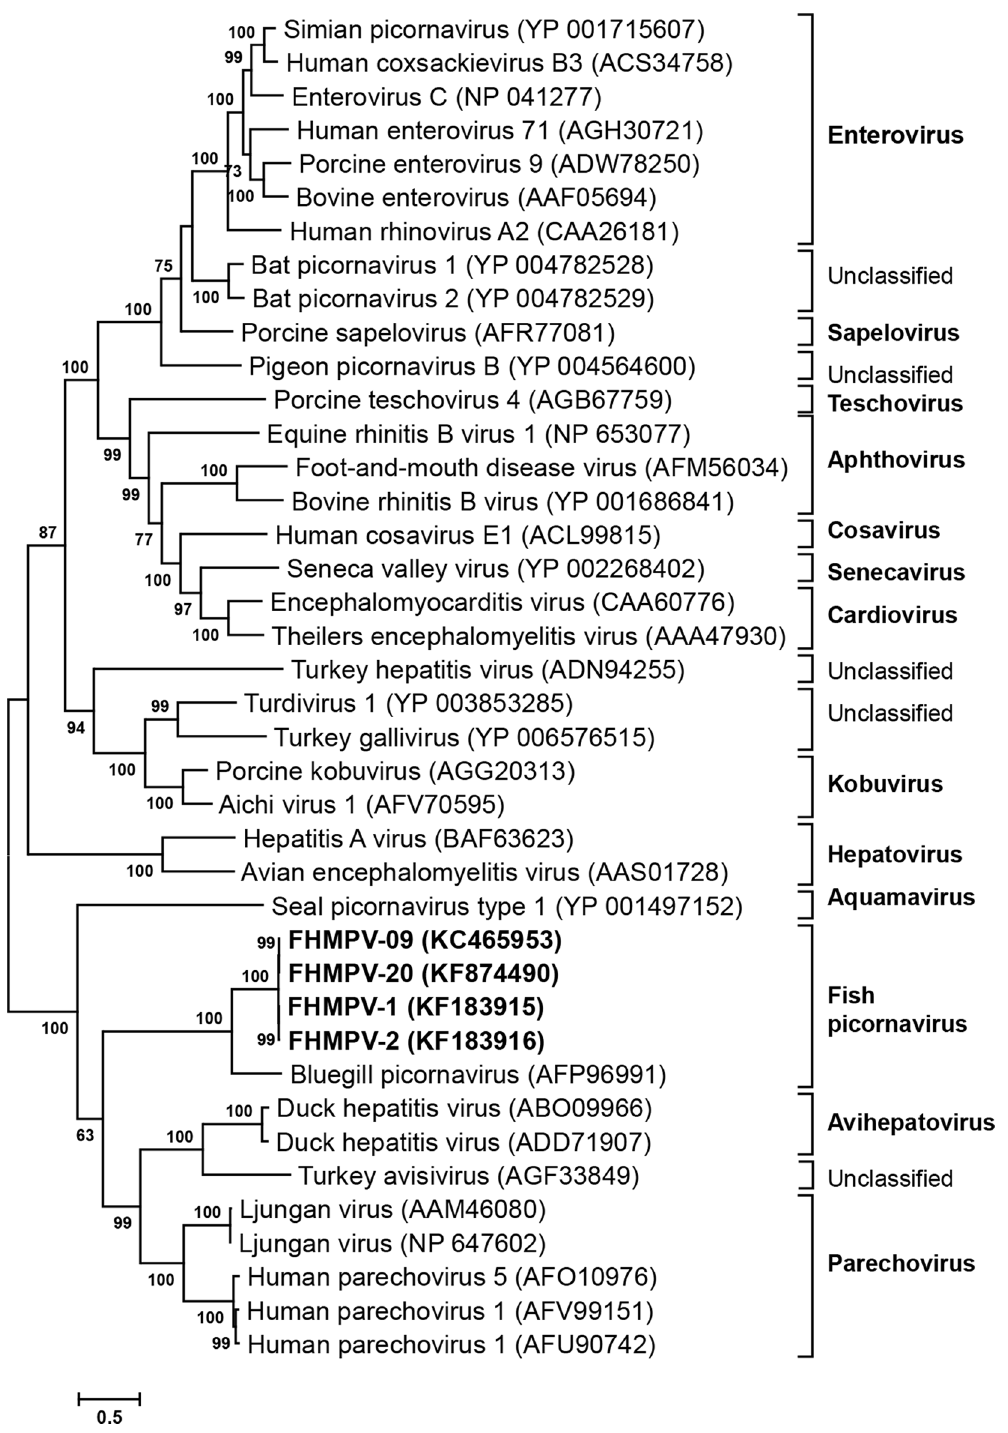
Figure 5. Phylogenetic analysis of picornavirus complete genome sequences. Phylogenetic analysis on the basis of complete genome (open reading frame) amino acid sequence of picornavirus. The evolutionary history was inferred using the Maximum likelihood method in MEGA5. The percentage of replicate trees in which the associated taxa clustered together in the bootstrap test (1,000 replicates) are shown next to the branches. The evolutionary distances were computed using the JTT + G + I and are in the units of the number of amino acid substitutions per site. doi:10.1371/journal.pone.0087593.g005 The sequence identities between FHMPV and BGPV of 58% (P1), indicate that FHMPV and BGPV could be considered prototypes 33% (P2) and 43% (P3) and the fact that both viruses share less of two new genera of Picornaviridae . We propose the novel genus than 40% sequencing identify with members of other genera